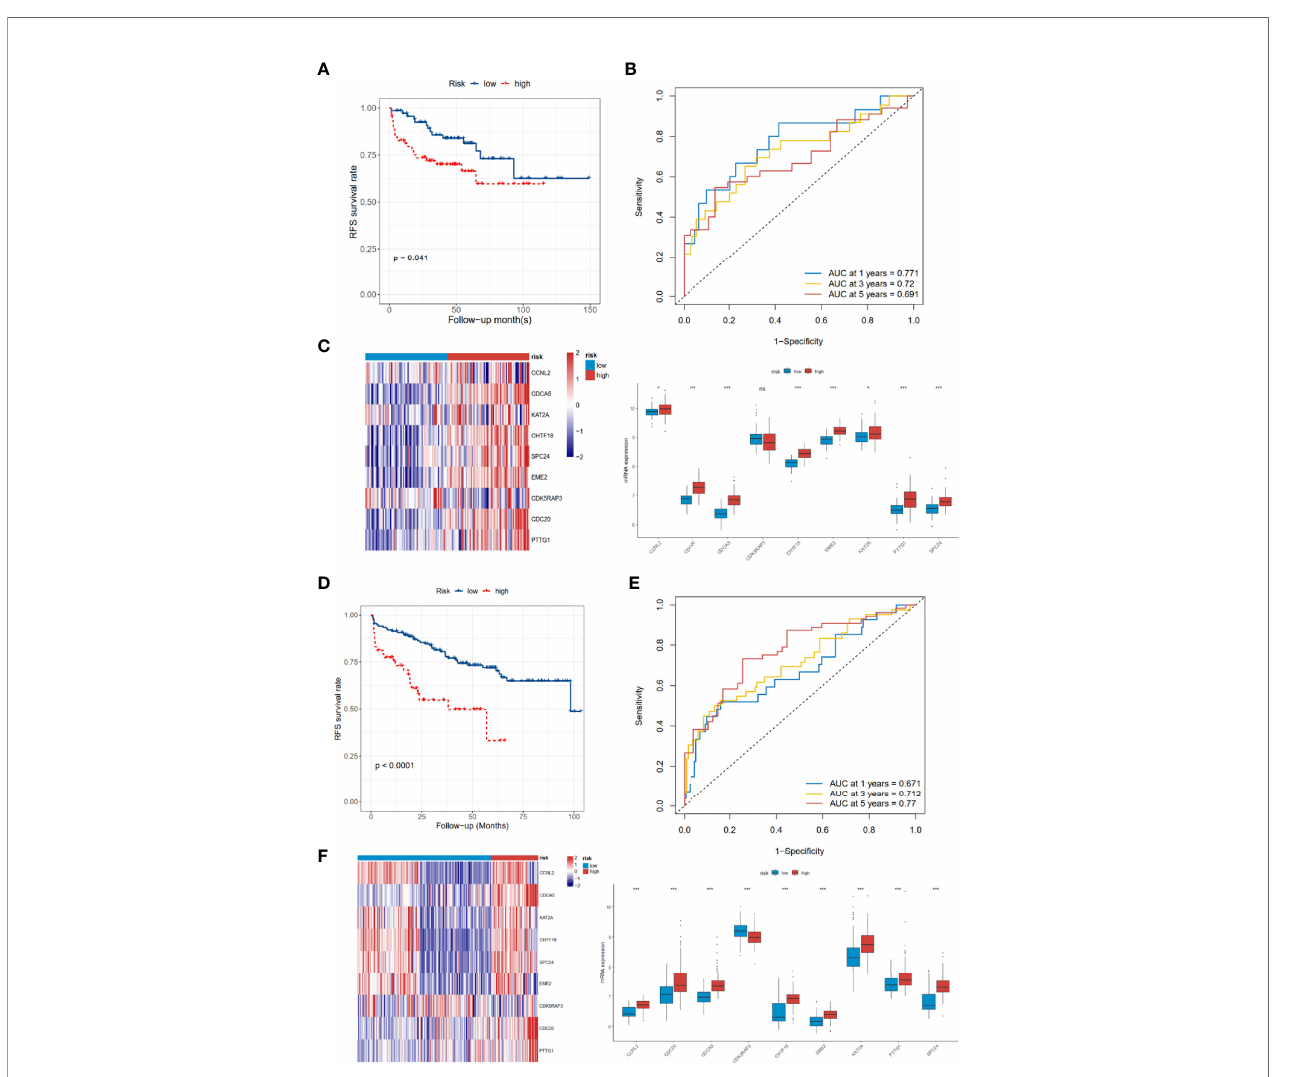
FIGURE 3 | Validation of the 9-gene signature in the MSKCC and GSE70770 cohort. (A – C) The distribution of RFS, RFS status, KM curves, and ROC curves in the MSKCC cohort. (D – F) The distribution of RFS, RFS status, KM curves, and ROC curves in the GSE70770 cohort. MSKCC, Memorial Sloan Kettering Cancer Center; RFS, recurrence-free survival; KM, Kaplan – Meier; ROC, receiver operating characteristic. ns, no signi fi cance. * p < 0.05, *** p < 0.001.